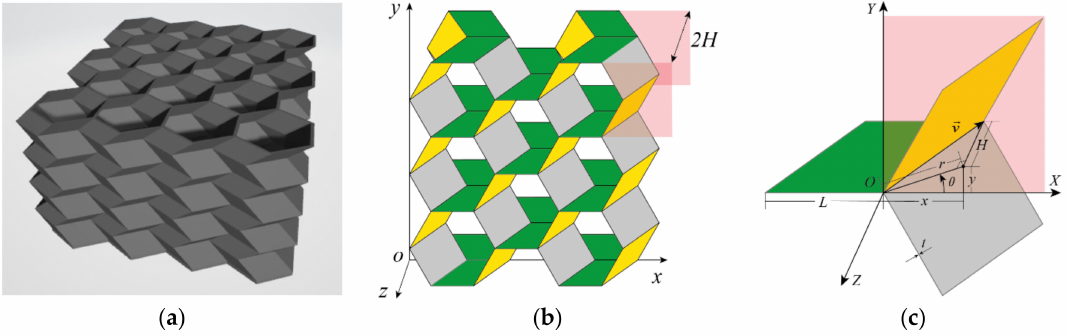
Figure 2. Geometric parameters of origami honeycomb structures: ( a ) overall structure, ( b ) coordinate diagram, and ( c ) geometric